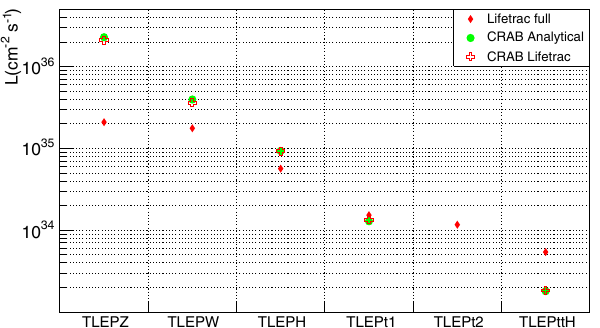
FIG. 6. Luminosity for different scenarios of TLEP operation. Red diamonds and red empty crosses are L IFETRAC simulations with full spectrum of beamstrahlung for Tables I and II, correspondingly; green dots are analytical calculations for the latter